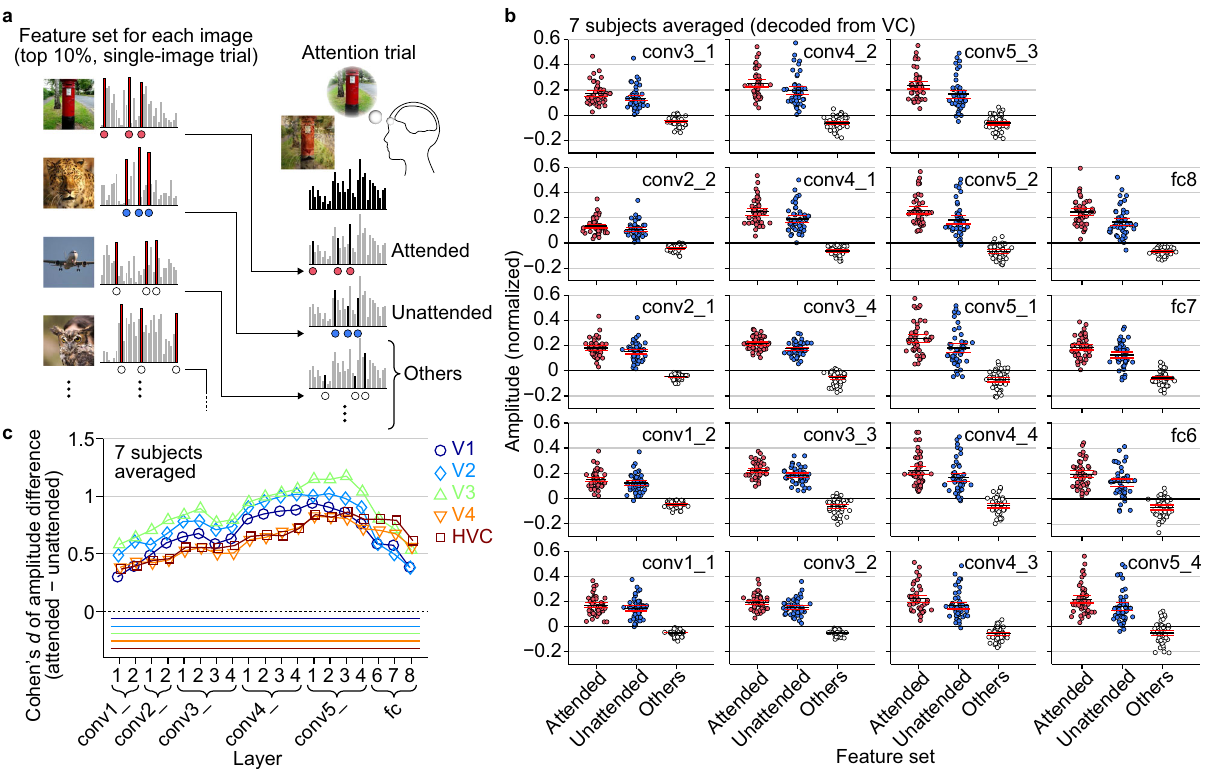
Fig. 5 Evaluation of amplitude modulations on decoded features. a Evaluation procedure by amplitude modulations. The amplitude of decoded features in each attention trial was evaluated for different sets of DNN features ( “ feature set ” for the attended image, the unattended image, and the other images; normalized by the values in training images for each unit; see Methods: “ Evaluation of amplitude modulations on decoded features ” ). b Amplitude of decoded features in attention trials (averaged across subjects). Mean amplitude averaged across units, trials, and subjects for the three types of feature sets are shown (decoded from VC; see Supplementary Fig. 6 for the results of individual subjects). Each dot indicates the mean amplitude of each image pair. Black and red lines indicate mean and lower/upper bounds of 95% C.I. across pairs. c Cohen ’ s d of amplitude differences between the attended and the unattended feature sets at visual subareas (averaged across subjects). The effect sizes (Cohen ’ s d ) of the amplitude differences are shown for each area and layer. Statistical analyses were performed with the Cohen ’ s d across 45 image pairs. Colored lines beneath data indicate the statistical signi fi cance of the difference (one-sided t -test, p < 0.01, Bonferroni correction by the numbers of brain areas and DNN layers). See Supplementary Fig. 7 for the results of individual